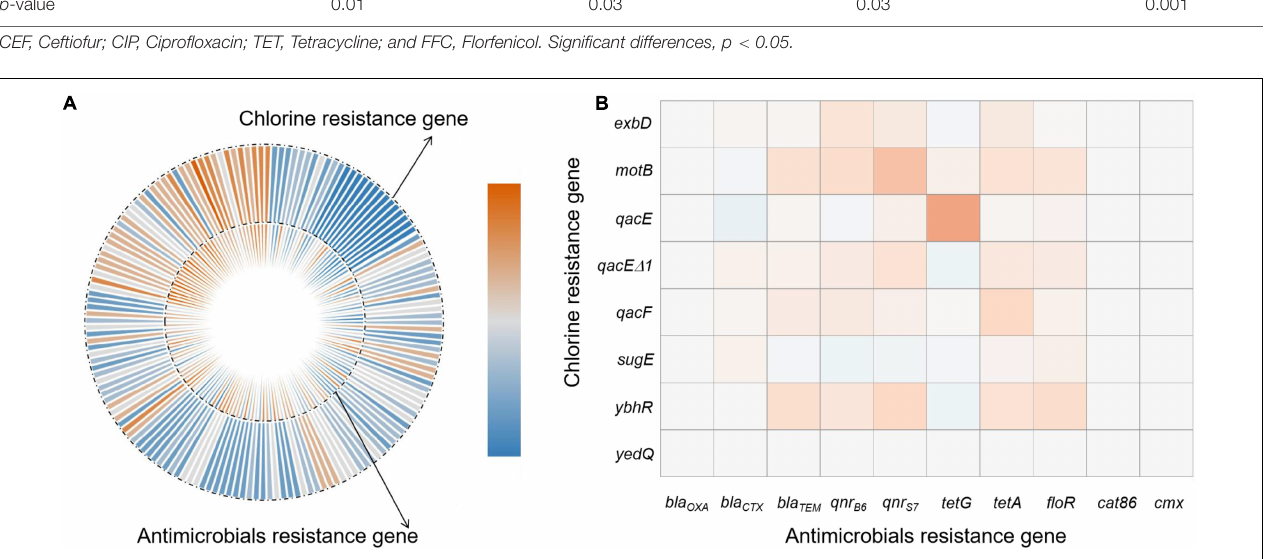
FIGURE 5 | Correlations of bacterial NaClO and antibiotic l resistance genes based on (A) correlation coefficient and (B) frequency of resistance gene